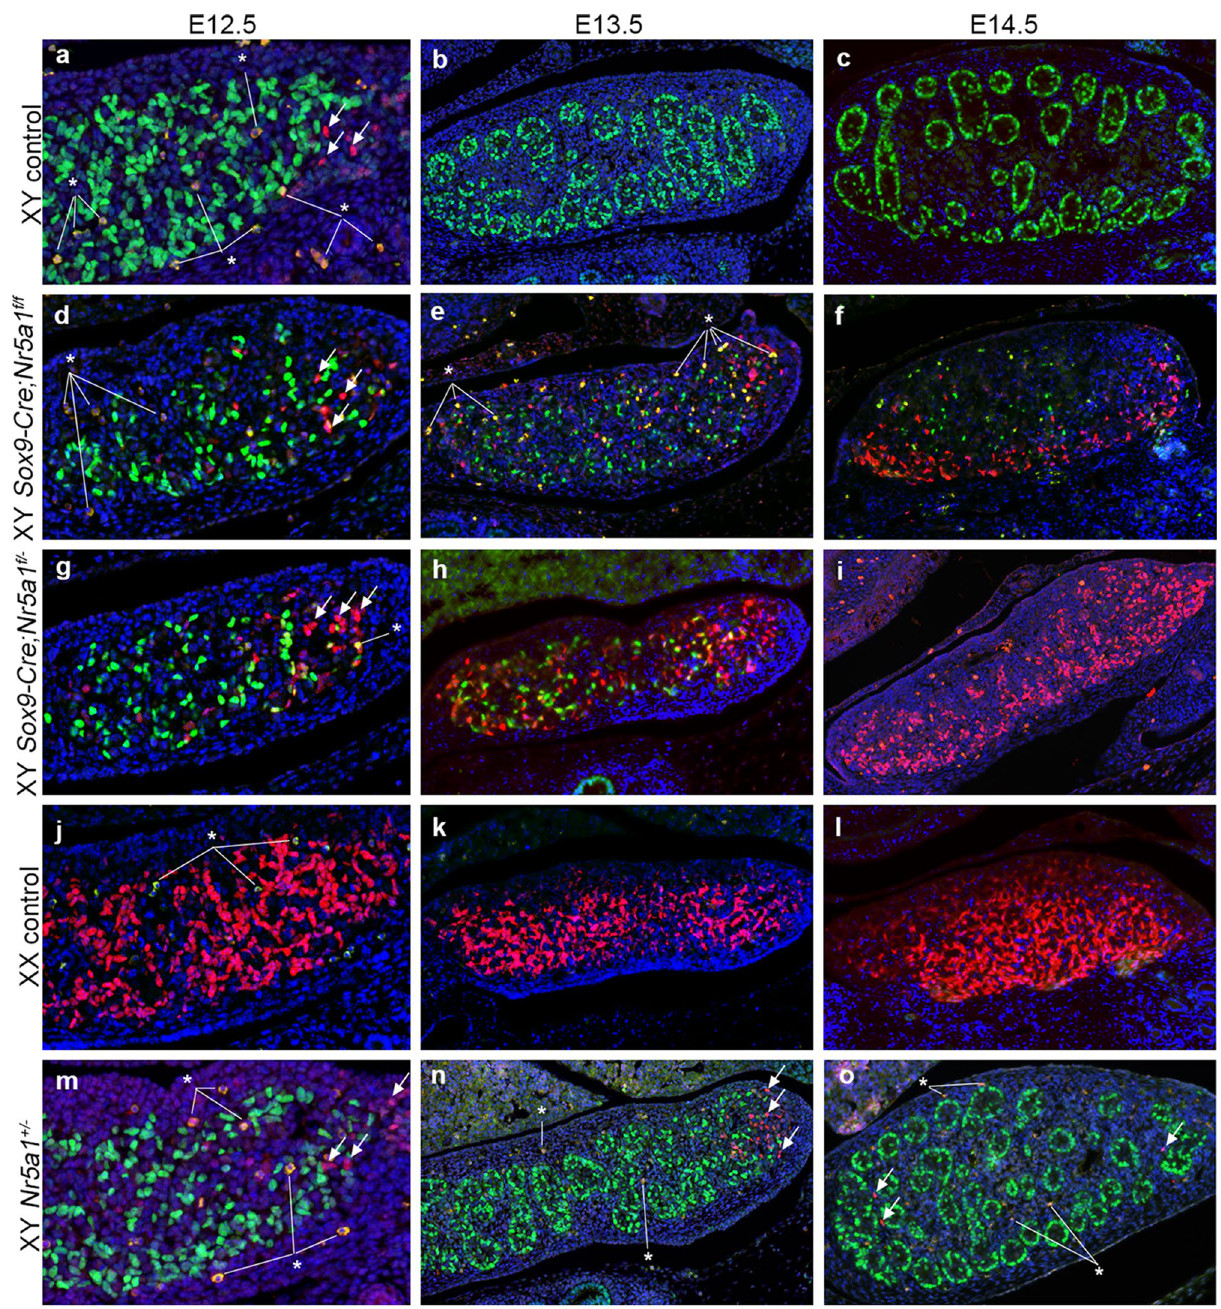
Figure 3. Sexual differentiation of supporting cells in XY Sox9-Cre - Nr5a1 cKO gonads. Double IHC for Sertoli cell marker SOX9 (green) and granulosa cell marker FOXL2 (red) in gonads of XY control ( a – c ), XY Sox9-Cre;Nr5a1f. /f ( d – f ), XY Sox9-Cre;Nr5a1f. /− ( g – i ), XX control ( j – l ), and XY Nr5a1 + /− ( m – o ) mice at E12.5, E13.5, and E14.5 (left, middle, and right panels, respectively). Ventral, anterior, and posterior sides of gonad are upwards, right, and left, respectively. White arrows indicate representative FOXL2 + cells in XY gonads. White asterisks indicate nonspecific autofluorescence. Nuclei are stained blue with DAPI. Scale bar, 50 µm in ( a , d , g , j , m ), 100 μm in ( b , c , e , f , h , i , k , l , n , o